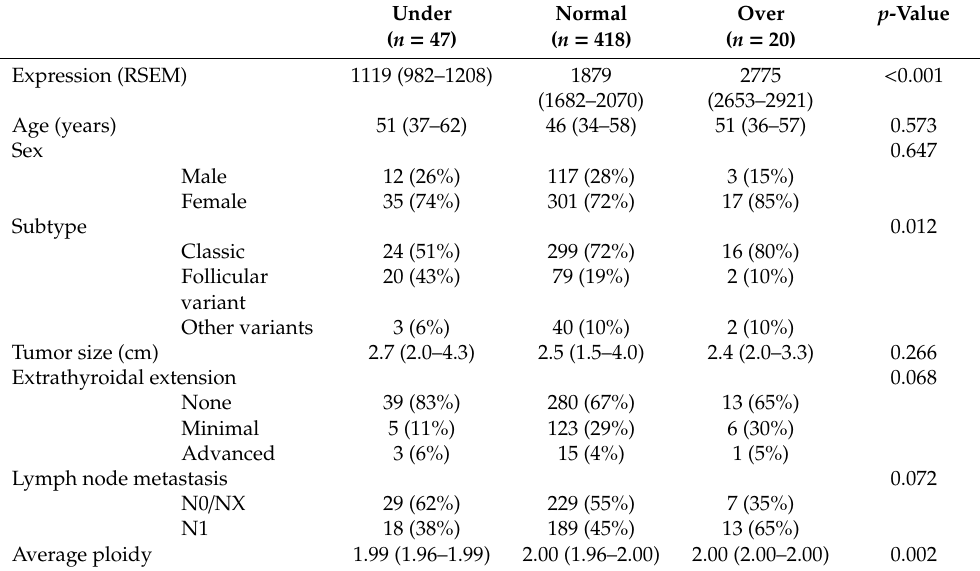
Table 2. Clinicopathological features of 485 patients with papillary thyroid cancer (THCA) from The Cancer Genome Atlas (TCGA) database stratified by the expression of SMARCB1. RSEM: RNA-Seq by Expectation